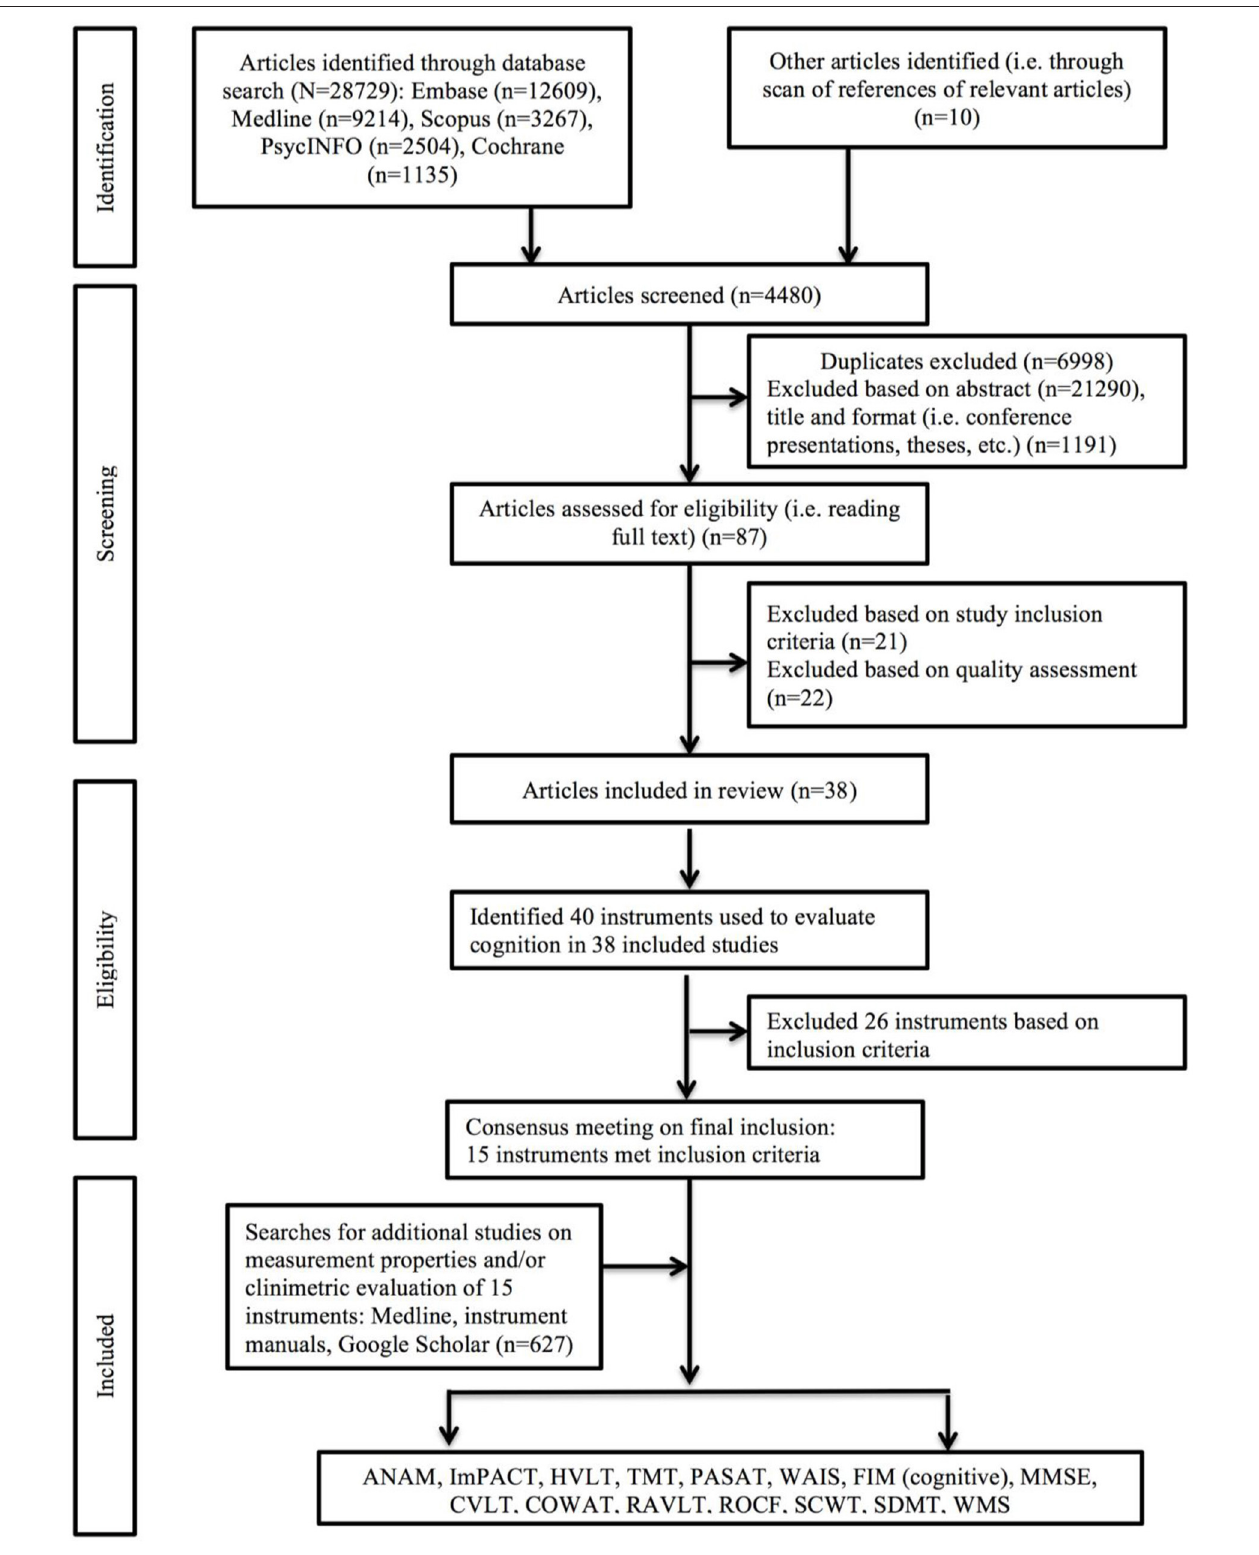
FIGURE 1 | Flow chart documenting review